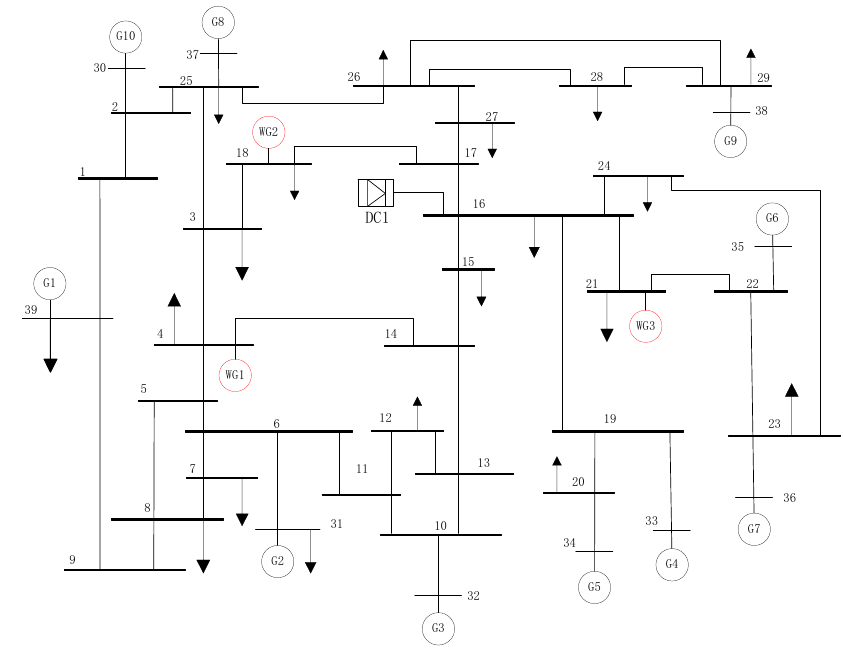
Figure 15. Modified IEEE 39-node test system.